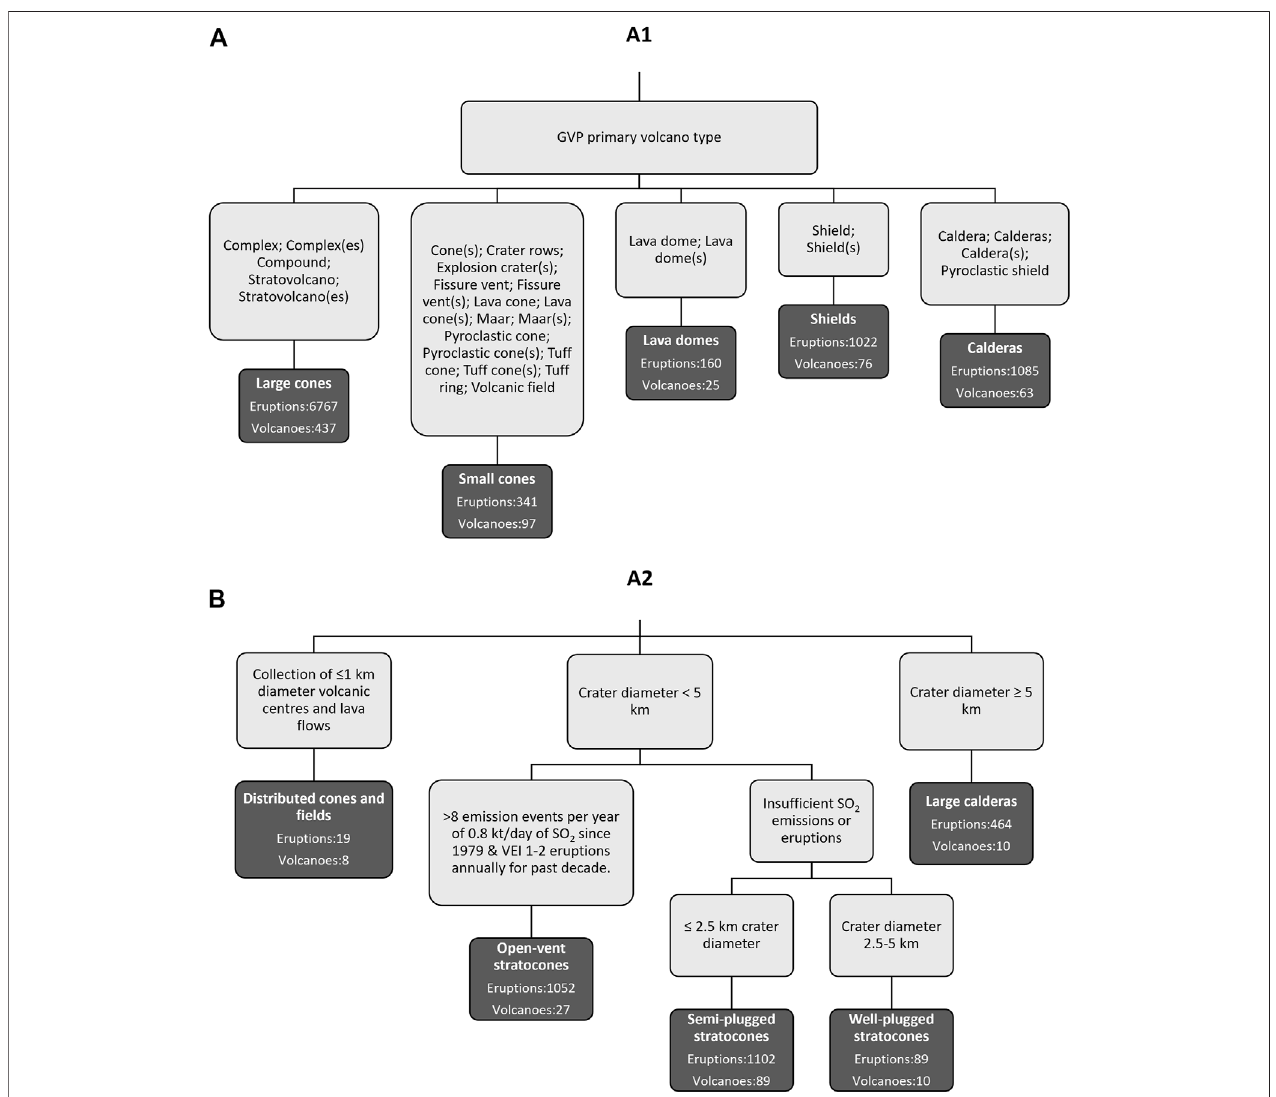
FIGURE2| Analogueclassi fi cationsystem,andthenumberoferuptionsandvolcanoesineachanaloguesubset,for (A) A1approach(Jenkinsetal.,2012),and (B) A2 approach (Whelley et al., 2015).